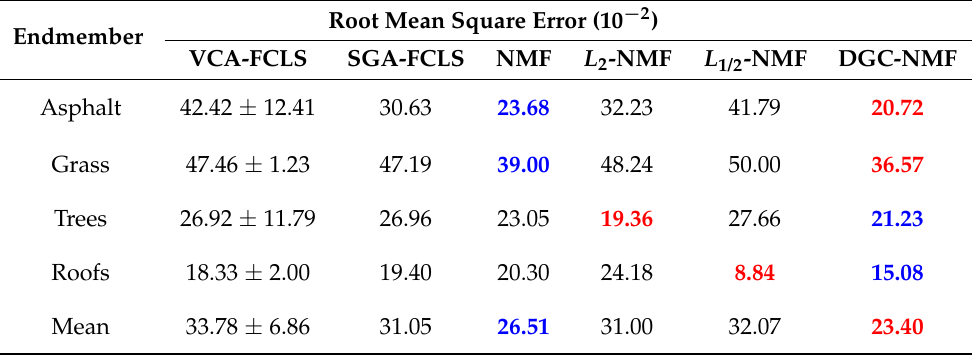
Table 3. RMSEs and their standard derivations of algorithms on the urban